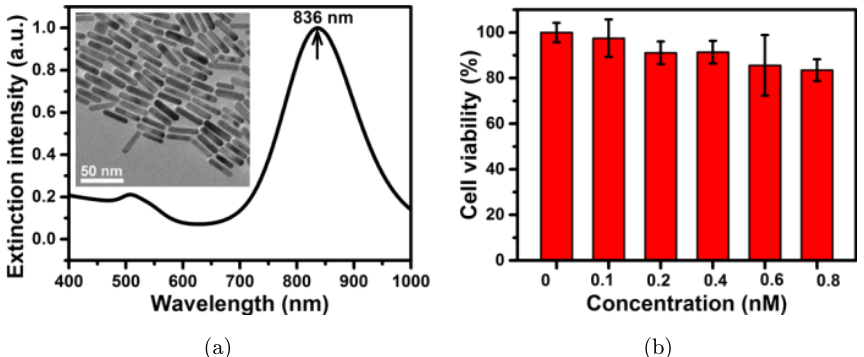
Fig. 4. (a) Extinction spectrum of PEG-GNRs and TEM image (inset) and (b) Cytotoxicity analysis of